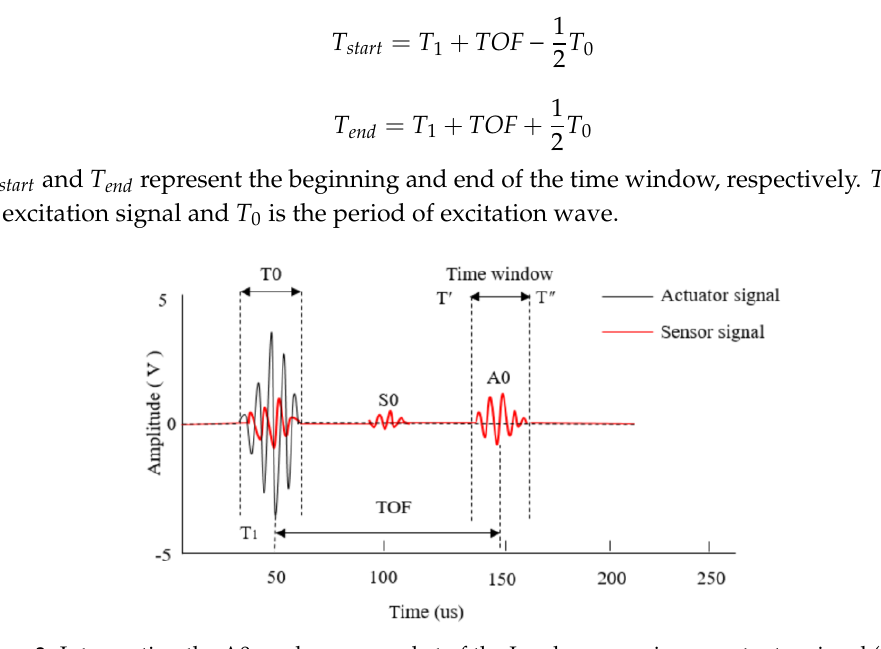
Figure 3. Intercepting the A0 mode wave packet of the Lamb wave using an actuator signal (in black) and a sensor signal (in red).